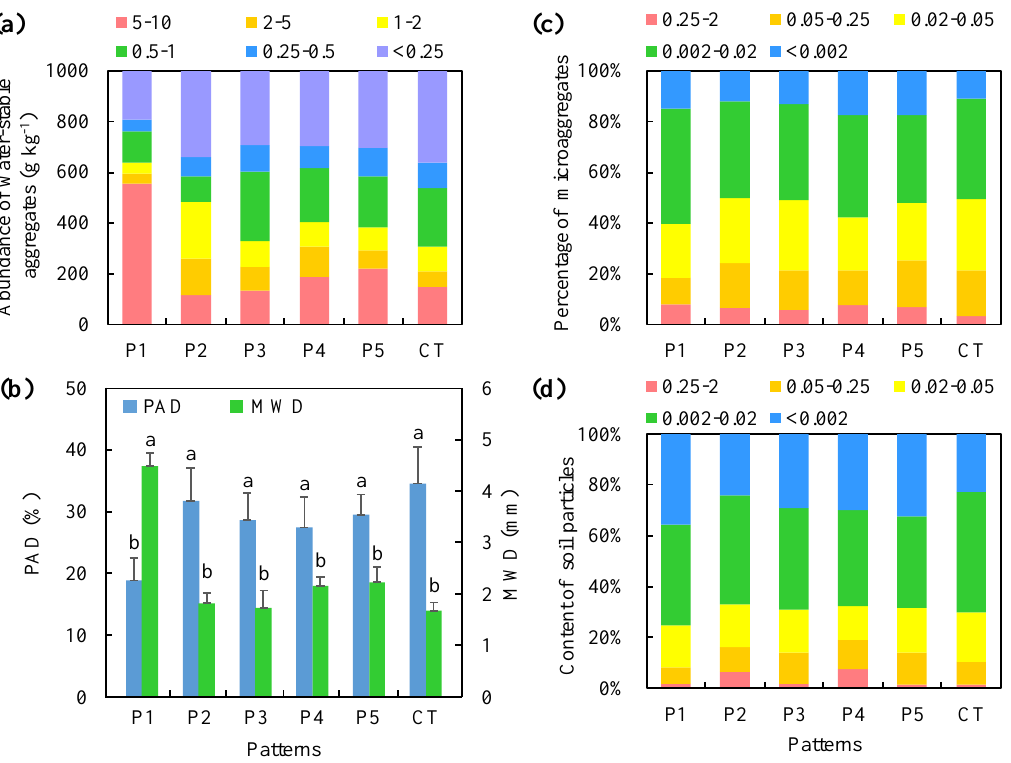
Figure 3. Soil aggregate structure and particle characteristics under di ff erent crop-mulberry planting patterns. ( a ) Water-stable aggregates; ( b ) mean weight diameter (MWD) of water-stable aggregates and percentage of aggregate destruction (PAD) for soil aggregates with a particle diameter > 0.25 mm; ( c ) microaggregates; ( d ) soil particle composition. The same letters above the bars indicate no significant di ff erence and di ff erent letters indicate significant di ff erences between these groups (p <